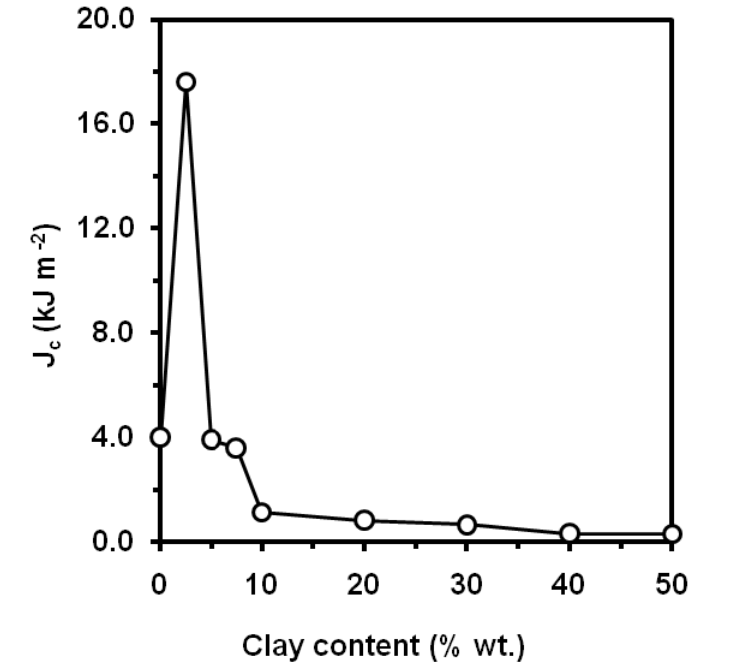
Figure 37. Influence of octadecylamine surface-treated montmorillonite content on J values (adapted from